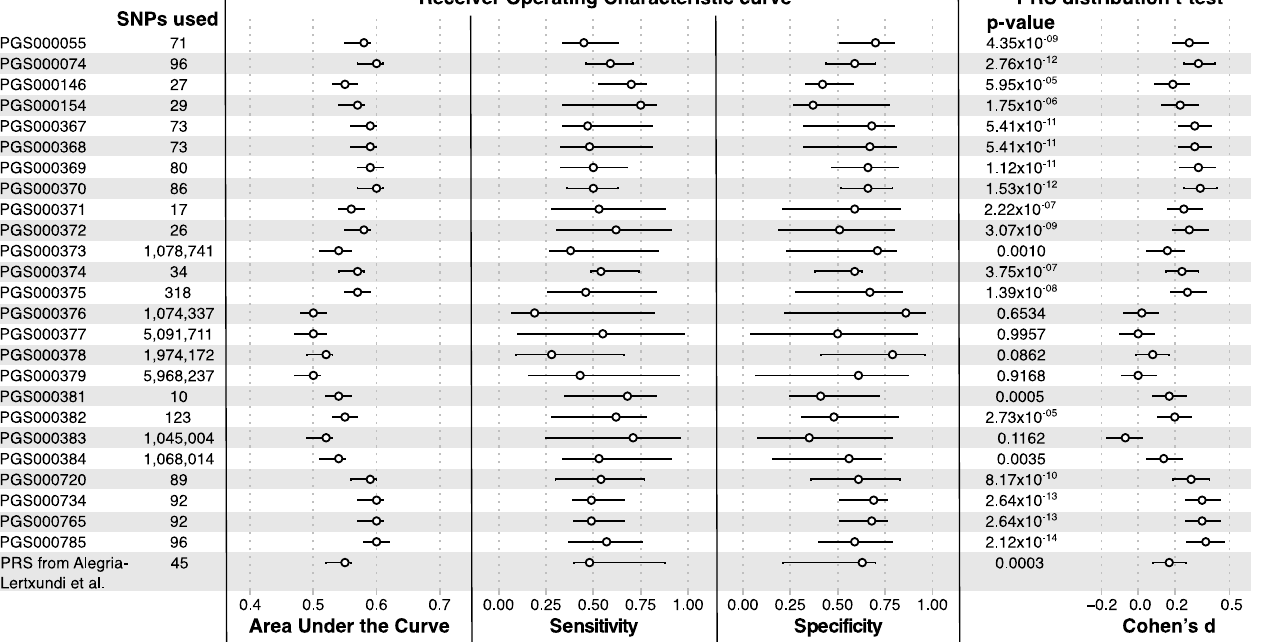
( p = 3.05 × 10 − 6 ), left colon cancer ( p = 7.49 × 10 − 6 ) and rectal cancer ( p = 3.33 × 10 − 6 ) compared